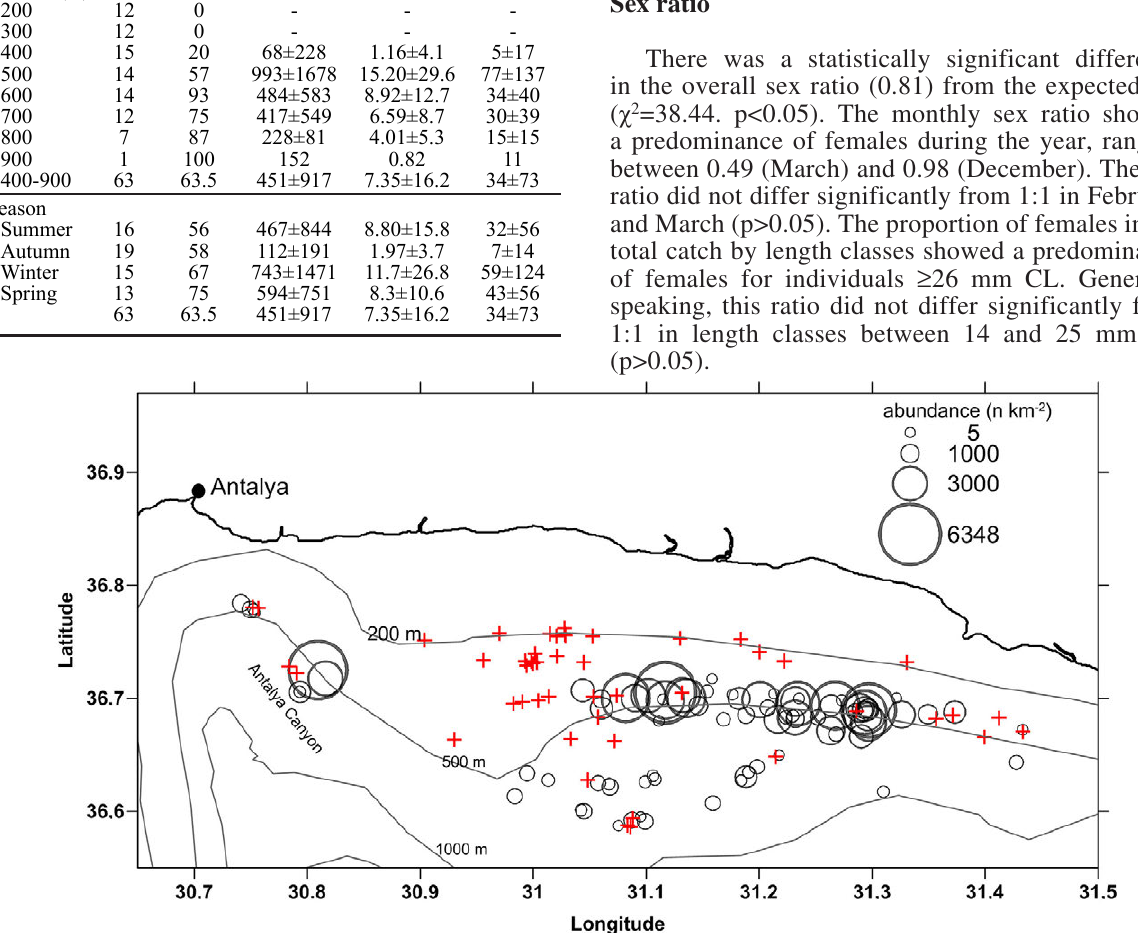
surveys.Fig. 4. – Overall abundance index of A. antennatus from all three surveys in Antalya Bay, ( + , specimens were not